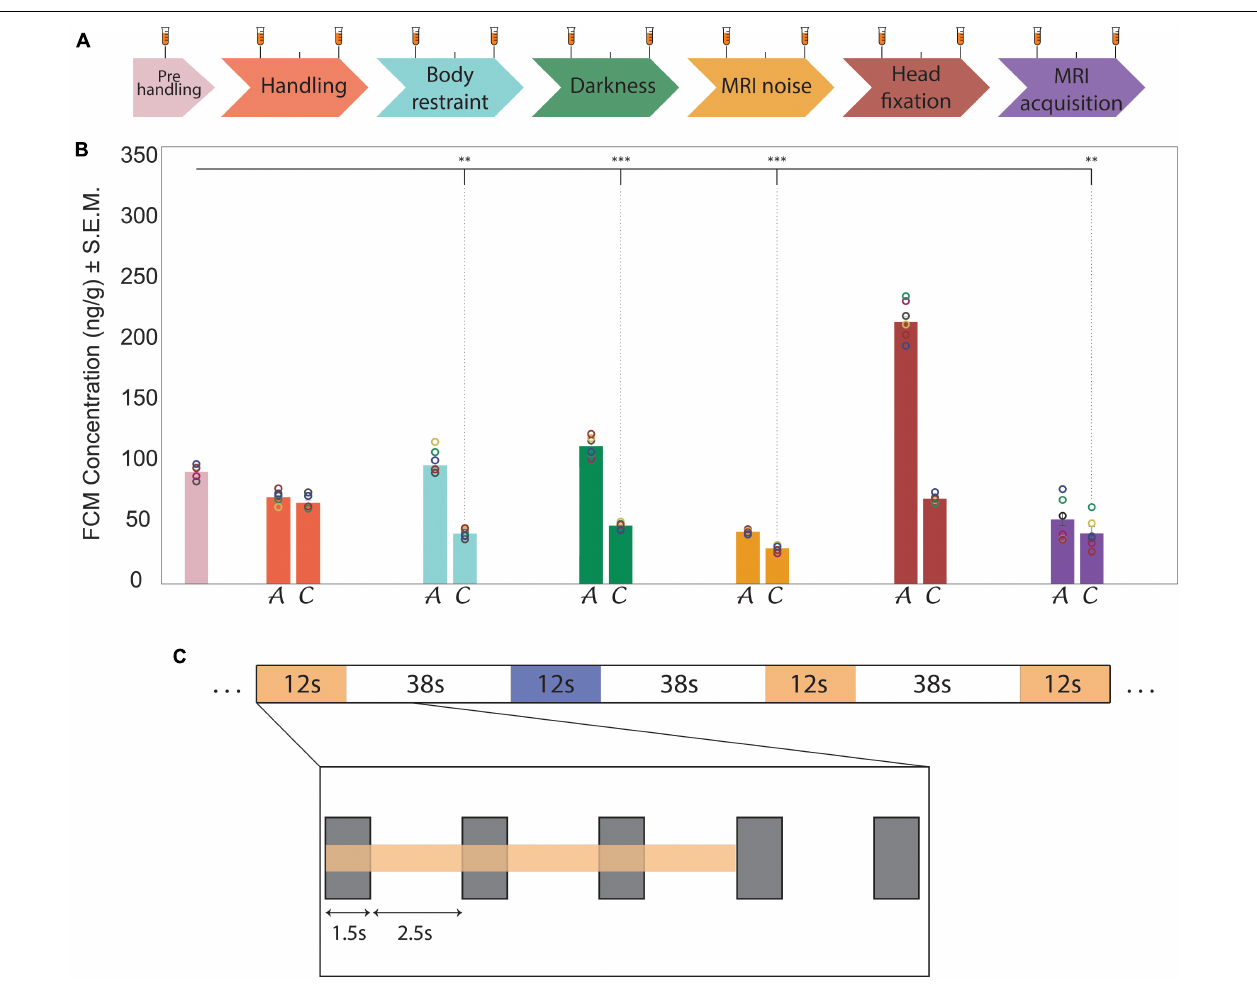
FIGURE 1 | Habituation protocol, stress level indicators of fecal corticosterone metabolites and experimental design of the auditory fMRI task. (A) Timeline representation of the habituation protocol that was designed to enable stable recordings during awake fMRI. (tick, 24 h; white space, 48 h break; long tick with test tube, stress sample collection, short tick, habituation without stress sample collection). (B) Bar charts show results from fecal corticosterone metabolite (FCM) assessments ( n = 6). Circles indicate the single values obtained in the animals for each evaluation step. The bar chart colors correspond to the habituation and recording steps shown in the timeline in part (A) . In each step, bar chart A reports the acute FCM levels and bar chart C reports the chronic FCM levels. FCM concentration is expressed as ng of FCM per g of fecal matter. Significance (One Way ANOVA) vs. pre-handling levels: ∗∗ p ≤ 0.01, ∗∗∗ p ≤ 0.001. During the last phase of the habituation protocol FCM levels are significantly lower than pre-handling levels ( t (5) ≥ 5.25, p < 0.03, n = 6). (C) Schematic representation of the auditory task. The two acoustic stimulation patterns (signified in yellow and blue) were randomly distributed during the sequence acquisition. A closer look at one sound stimulation (inlay) shows the duration of the scanner noise (gray rectangles) - relative to the slice acquisition period (TA = 1.5 s). This occurred at the beginning of each TR and was followed by a quiet period (no slice acquisition noise) of 2.5